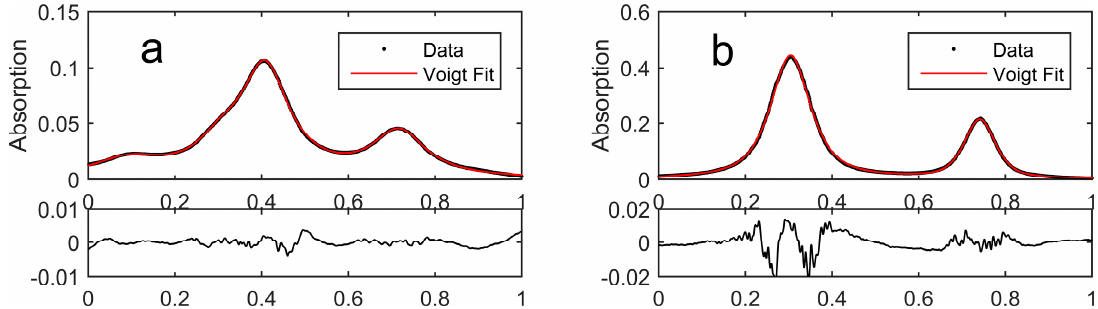
Figure 3. Measured spectrum (top) along a normalized scale with Voigt fit (red), and (below) residual (black) for line pairs 13 C/ 12 C ( a ) and D/H ( b ). The residual is calculated by subtracting the fitted values from measurement data.